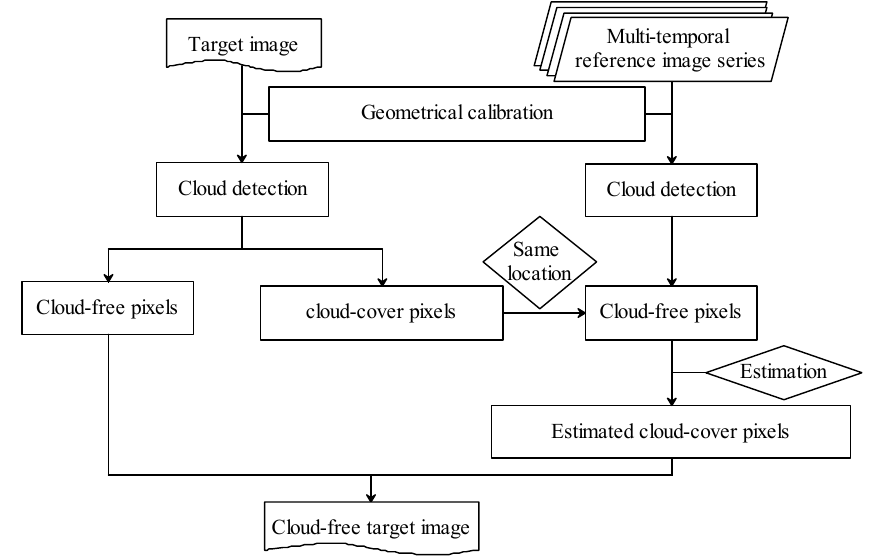
Figure1. Figure 1. Framework illustrating the approach for cloud removal using multi-temporal reference images.